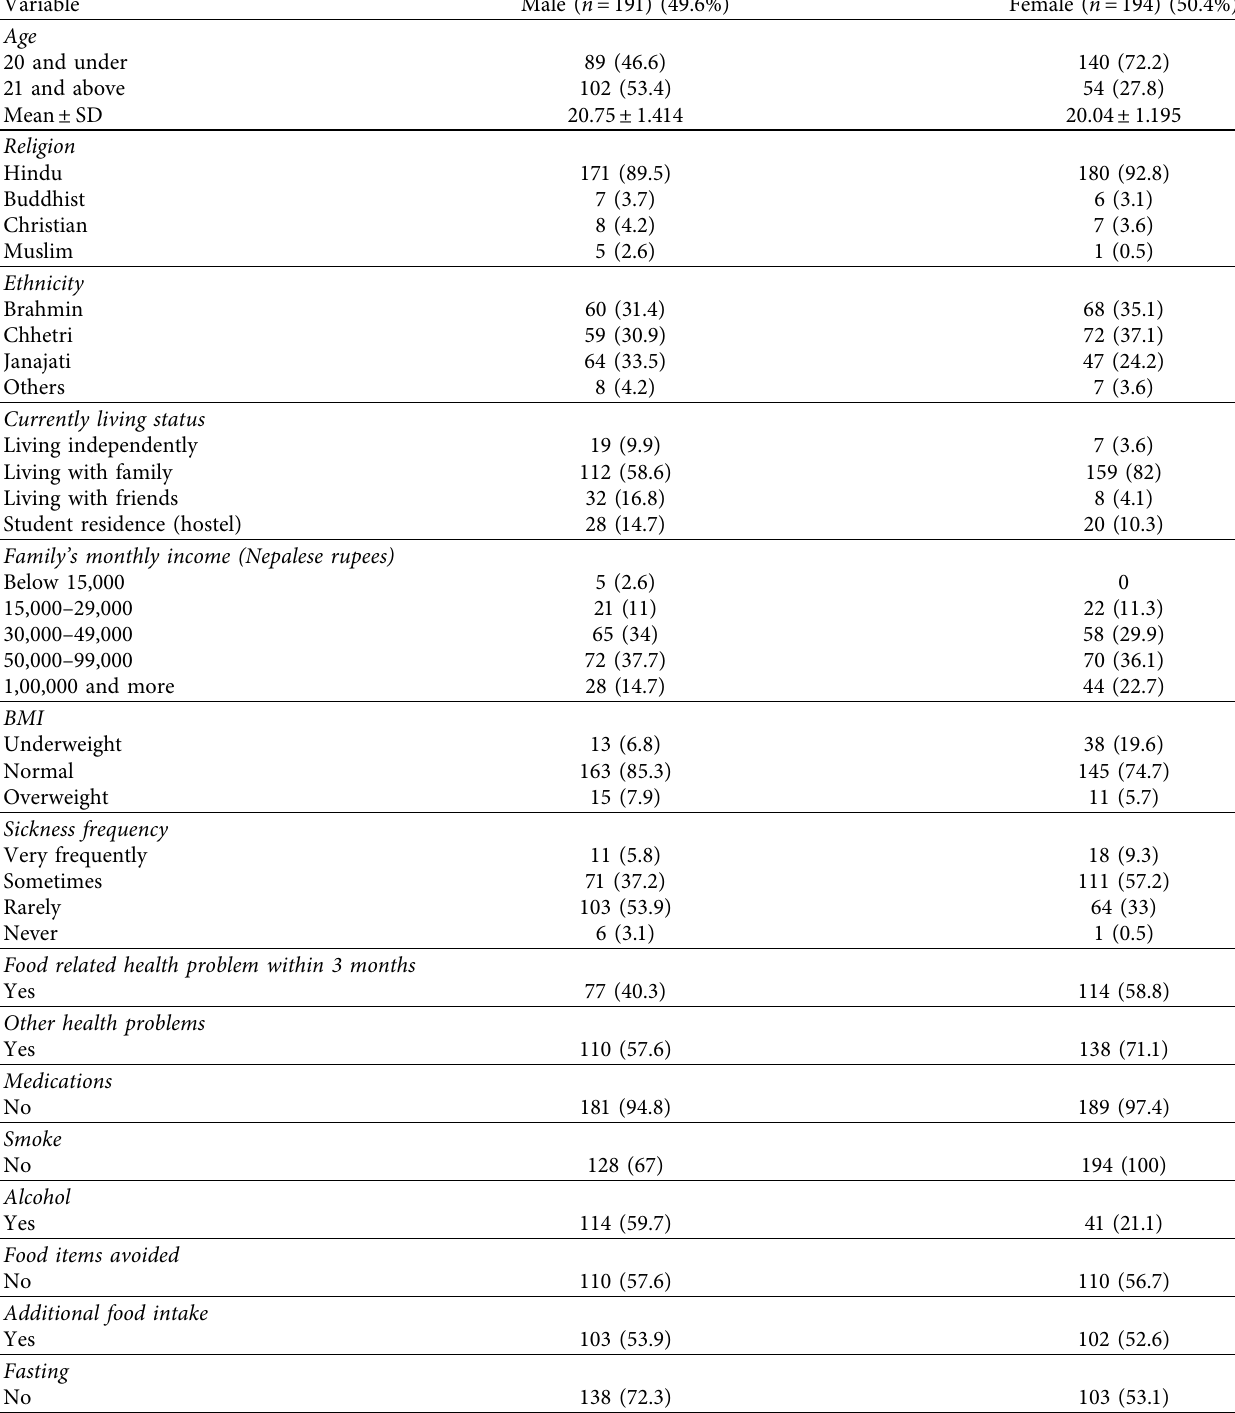
Table 1: Sociodemographic characteristics, health status, and behavioural factors of the respondents ( n � 385).